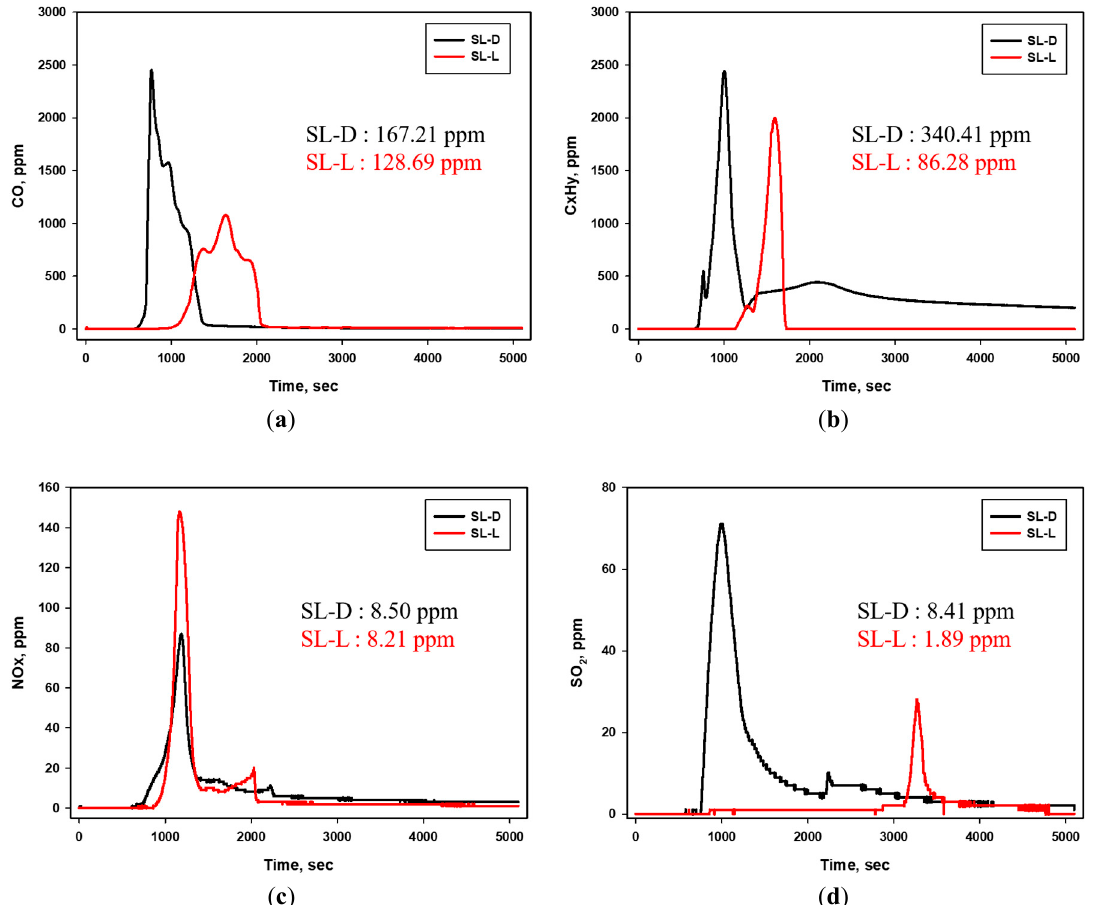
Figure 6. Flue gas emissions of SL-D and SL-L-10: ( a ) CO gas, ( b ) CxHy gas, ( c ) NOx, ( d ) SO 2 . In comparison, the release of flue gas from the HSF samples was lower. The reduction of the CO gas emissions were calculated to be 27.69% (SW-L-10), 32.18% (DS-L-10), and 23.04% (SL-L-10), as the ratio decreased (the reduction ratio of C x H y gas: SW-L-10 39.50%, DS-L-10 58.54%, and SL-L-10 74.65%, see Figures 4, 5 and 6b). The experimental results show that oxygen and hydrogen contents